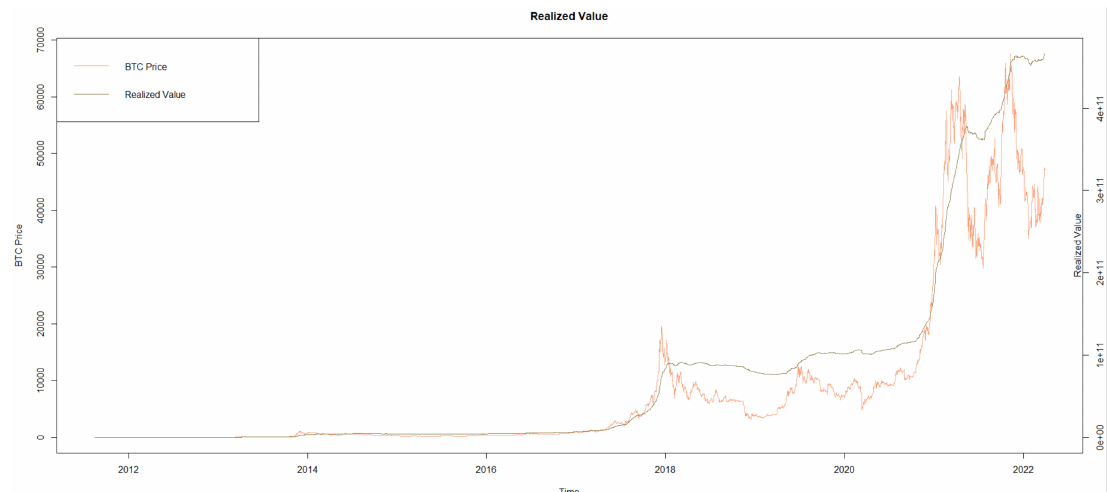
Figure 3. Bitcoin price and realized